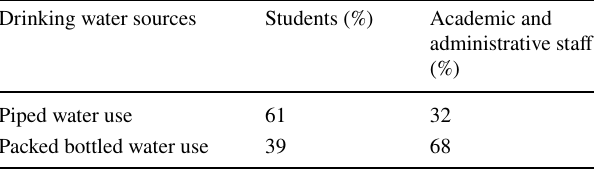
Table 5 Drinking water sources in ASTU based on drinking water consumption